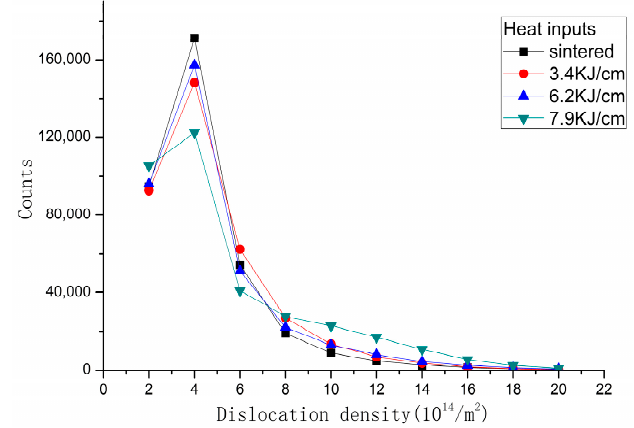
Figure 6. Dislocation density.